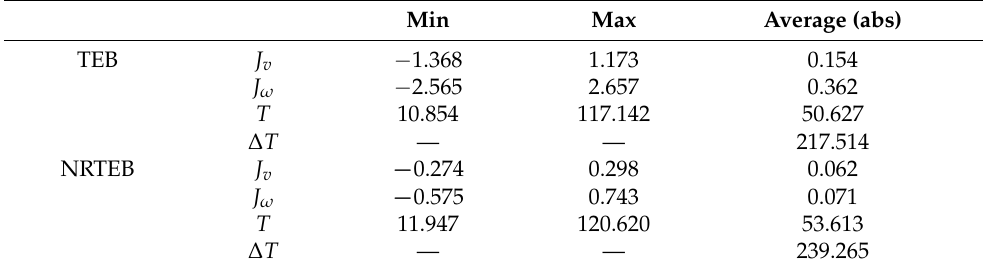
Table 8. Planning performance